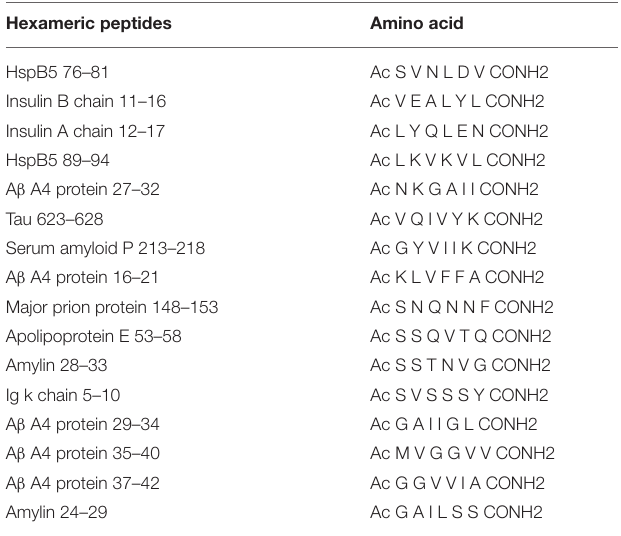
TABLE 3 | Hexapeptide-containing amyloid fibrils with therapeutic potentials for experimental autoimmune encephalomyelitis. Hexameric